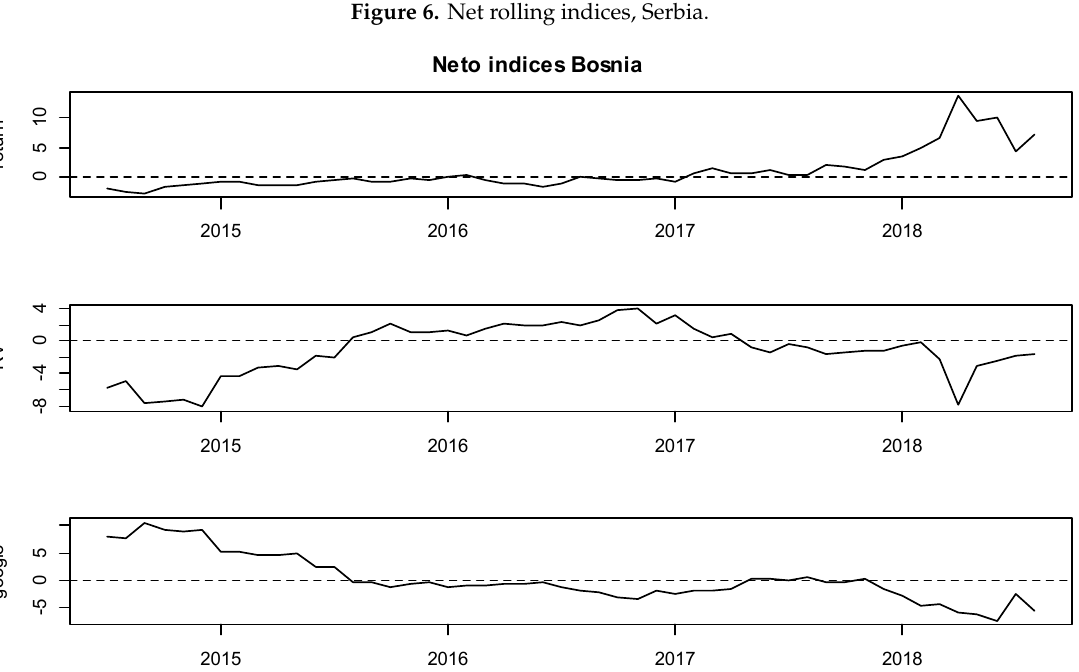
Figure 6. Net rolling indices, Serbia.